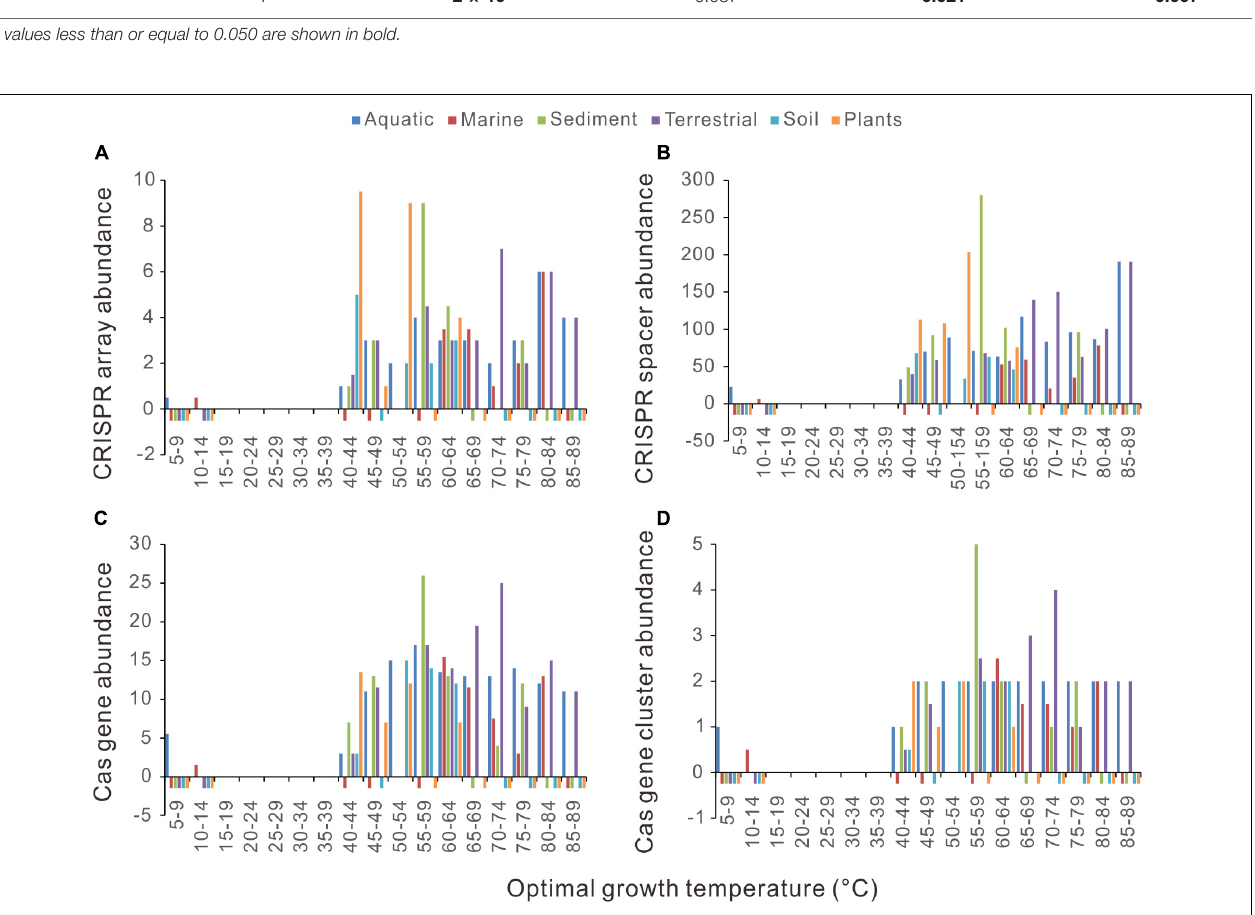
Frontiers in Microbiology |